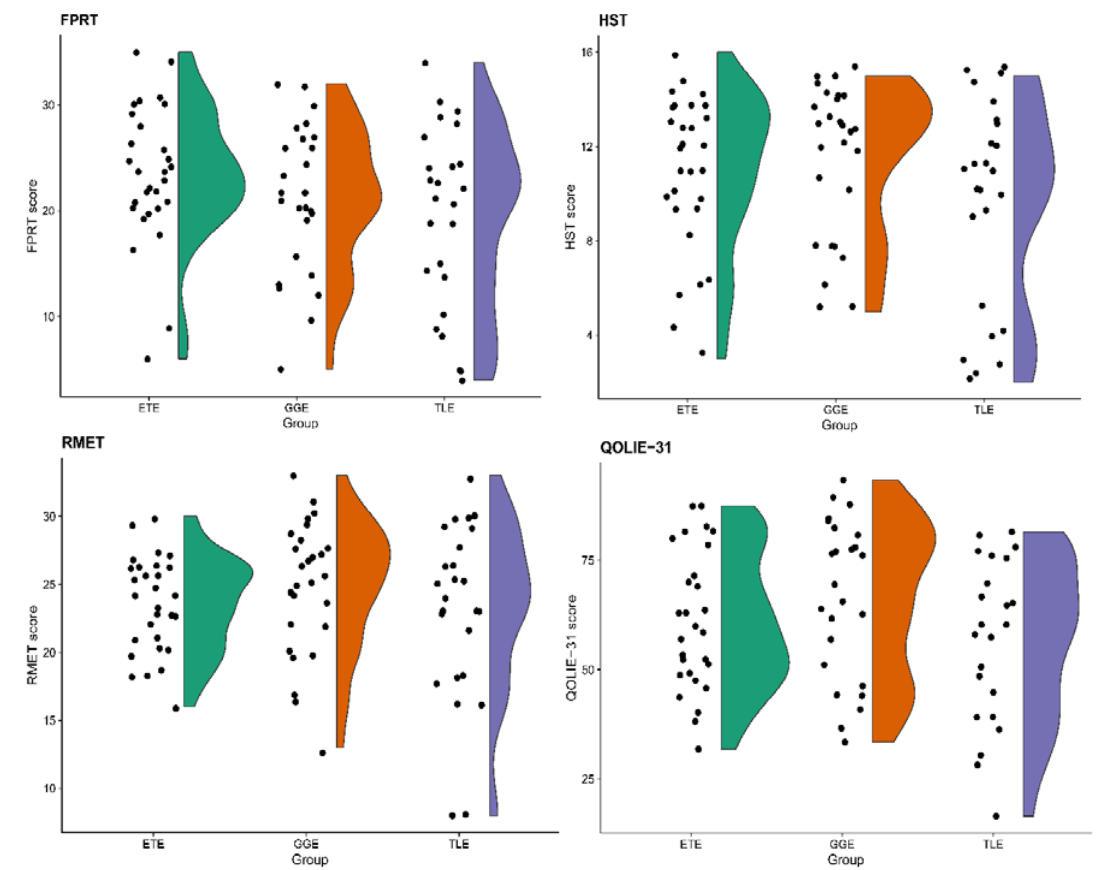
Figure 1. Raincloud plots for tasks of social cognition and quality of life scores among groups of patients with extratemporal (ETE), generalized (GGE) and temporal lobe (TLE) epilepsies. FPRT—faux pas recognition test (total score), HST—the Happé strange stories test, RMET—Reading of the Mind in the Eyes test, QOLIE-31—The 31-item Quality of Life in Epilepsy inventory (total score).